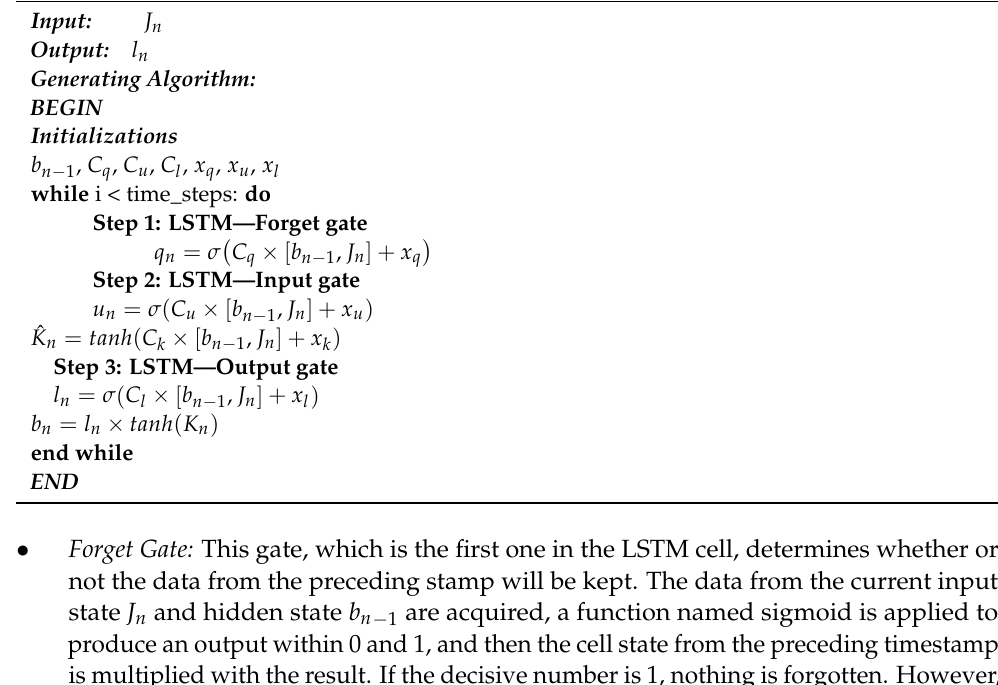
Algorithm 1: Computation algorithm of LSTM